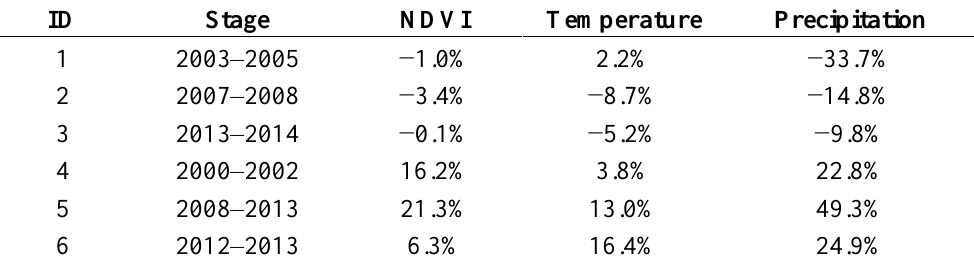
Figure 2. Variations in annual NDVI values in the Shaanxi-Gansu-Ningxia region from 2000 to 2014. Table 2. The changes of NDVI and associated factors during six